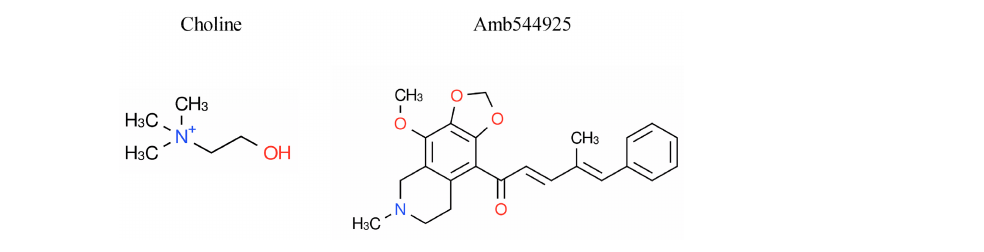
Figure 1. Chemical structure of choline (2-hydroxyethyl(trimethyl)ammonium), Amb544925 (1-(4-methoxy-6-methyl-5,6,7,8-tetrahydro-[1,3]dioxolo[4,5-g]isoquinolin-9-yl)-4-methyl-5-phenyl- penta-2,4-dien-1-one).